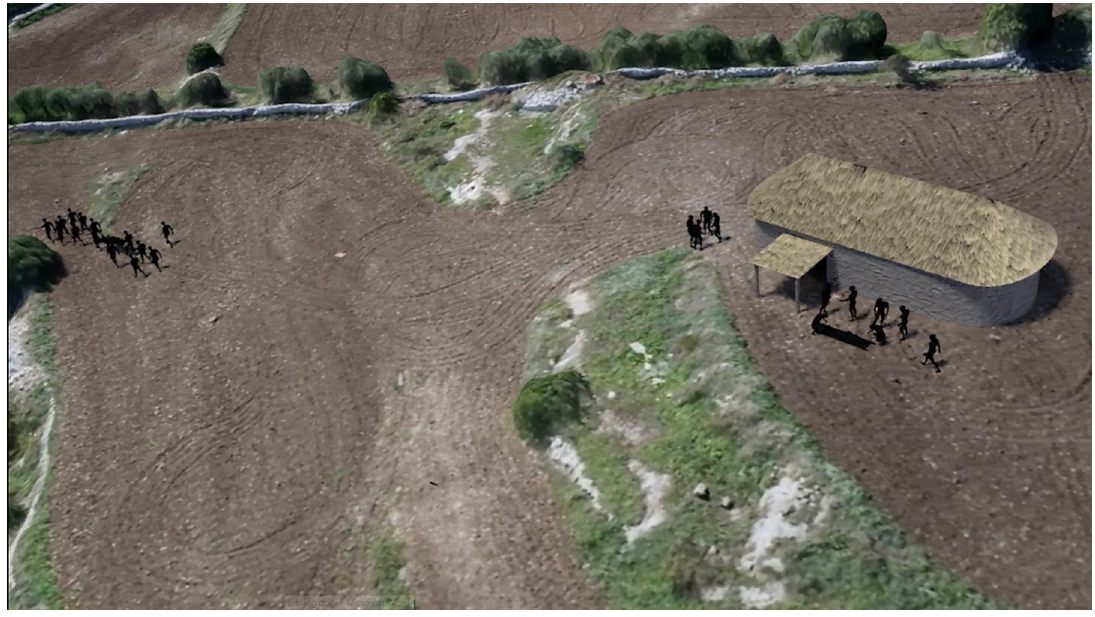
Figure 17. Funerary procession from the hut to the